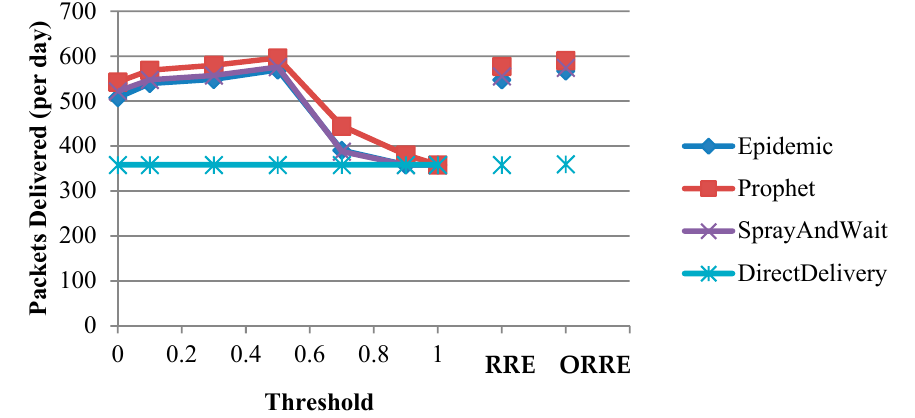
Figure 4. Packets delivered per day for Threshold, RRE and ORRE strategies for flying foxes.